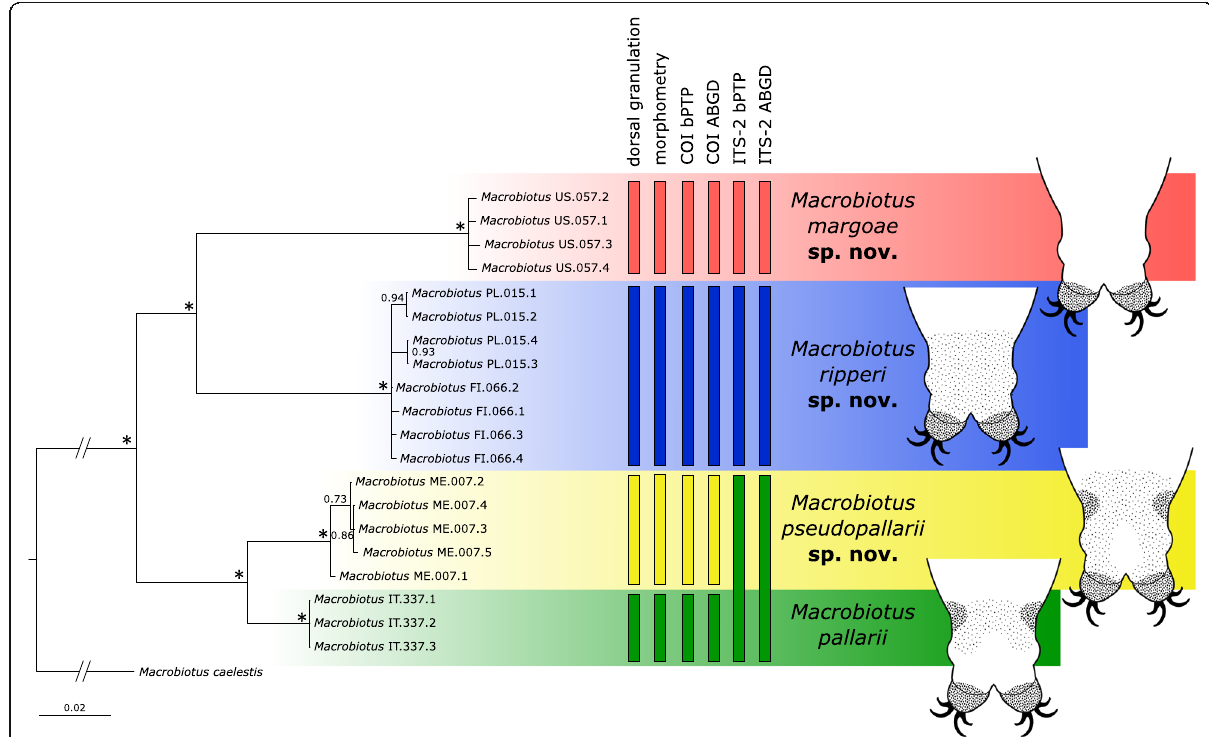
Fig. 1 BI Phylogenetic reconstruction of the relationships between the analyzed specimens from the 5 populations. Nodes with posterior probability (pp) <0.70 were collapsed; asterisks indicate nodes with pp=1.00. Vertical bars show the results of different species delimitation methods or discriminant characters. Horizontal colored boxes highlight the identified species described in the Taxonomic Account. A schematic representation of the dorso-caudal granulation patterns for each described species is presented (for a detailed description, see the Taxonomic